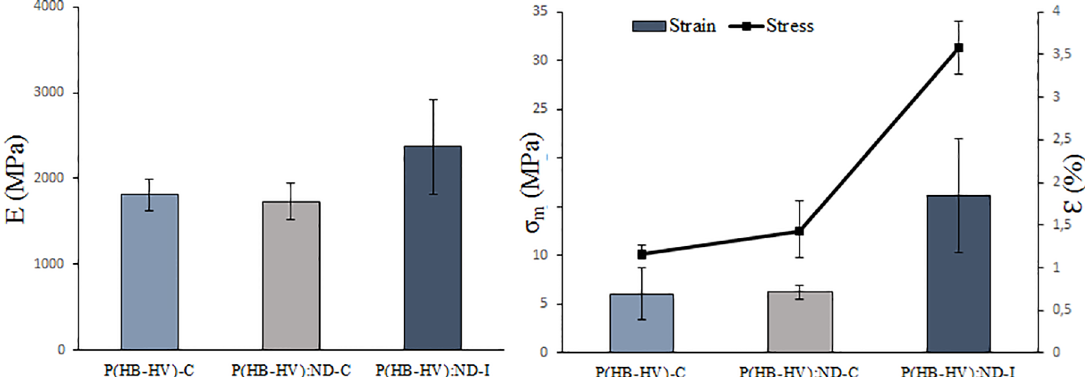
Figure 5. Mechanical Properties of different formulations obtained from three-point flexural test: Elastic modulus, maximum flexural stress and maximum strain.